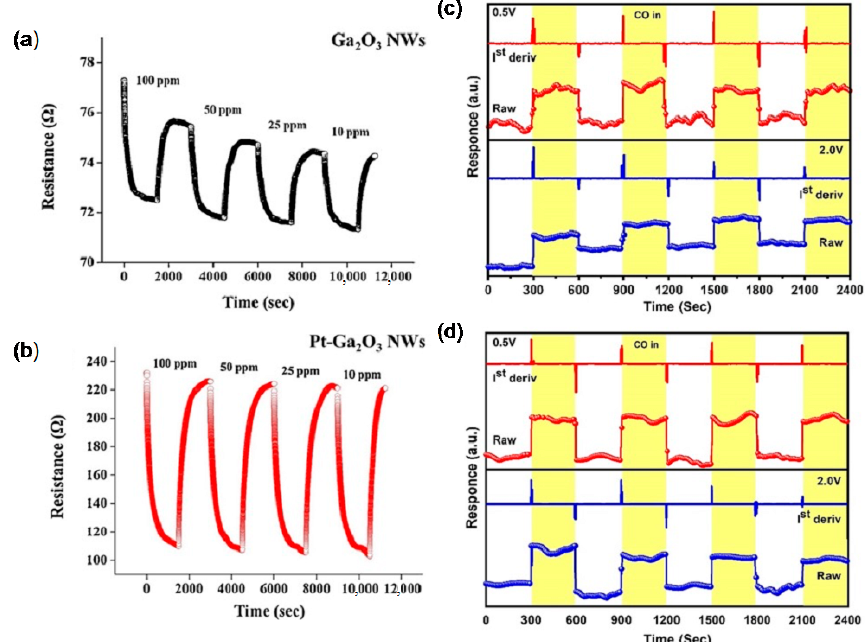
Figure 12. Gas responses of ( a ) bare Ga 2 O 3 nanowires and ( b ) Pt ‐ coated Ga 2 O 3 nanowires to 10, 25, 50, and 100 ppm CO gas at 100 °C [124]. Copyright 2012 Elsevier. Room temperature CO gas sensor measurement results with different bias voltages for ( c ) pure β‐ Ga 2 O 3 nanowires and ( d ) Au ‐ decorated β‐ Ga 2 O 3 nanowire with 2158 ppm CO concentration [140]. Copyright 2020 Elsevier.